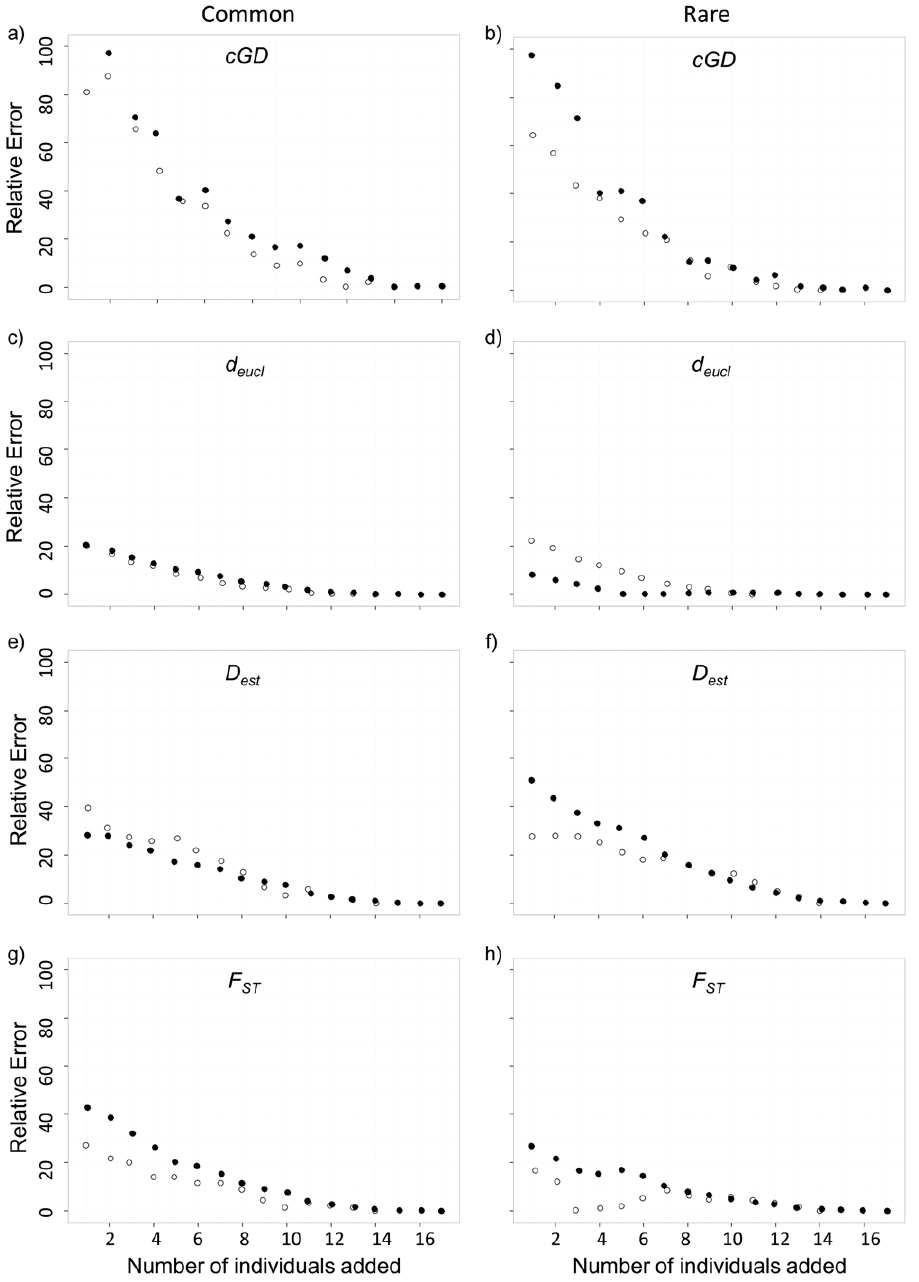
Figure 4. The effect of under-sampled sites on genetic distance estimates. We represented the marten ( Martes americana ) dataset with hollow symbols and the fisher ( M. pennanti ) dataset with filled symbols. We have presented values as the absolute relative error (%) between the mean pairwise genetic distance estimate at each iteration and the genetic distance estimate for the full dataset (‘true’ measure). Each iteration represents the addition of one individual to each site, such that in a, c, e, and g, the individuals added have common genotypes, and in b, d, f, and h, individuals added have rare genotypes (according to scores on the first principal component).